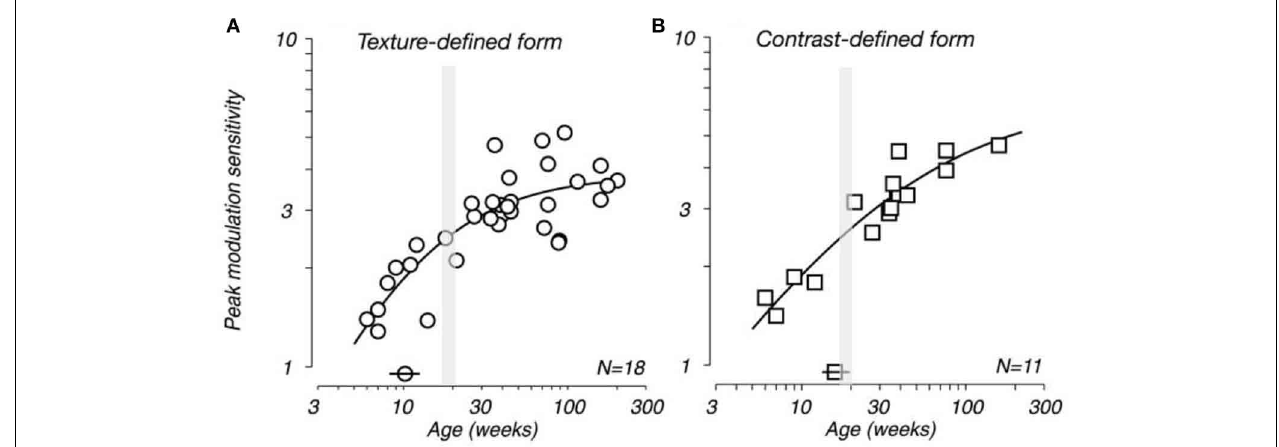
FIGURE 12 | Developing visual sensitivity. Plots illustrating the developmental time course of peak behavioral modulation sensitivity for (A) texture-defined and (B) contrast-defined form as a function of age. Isolated symbols intersected by horizontal bars (above the x-axis) indicate the age at which modulation sensitivity reached half of adult levels (10 and 17 weeks for